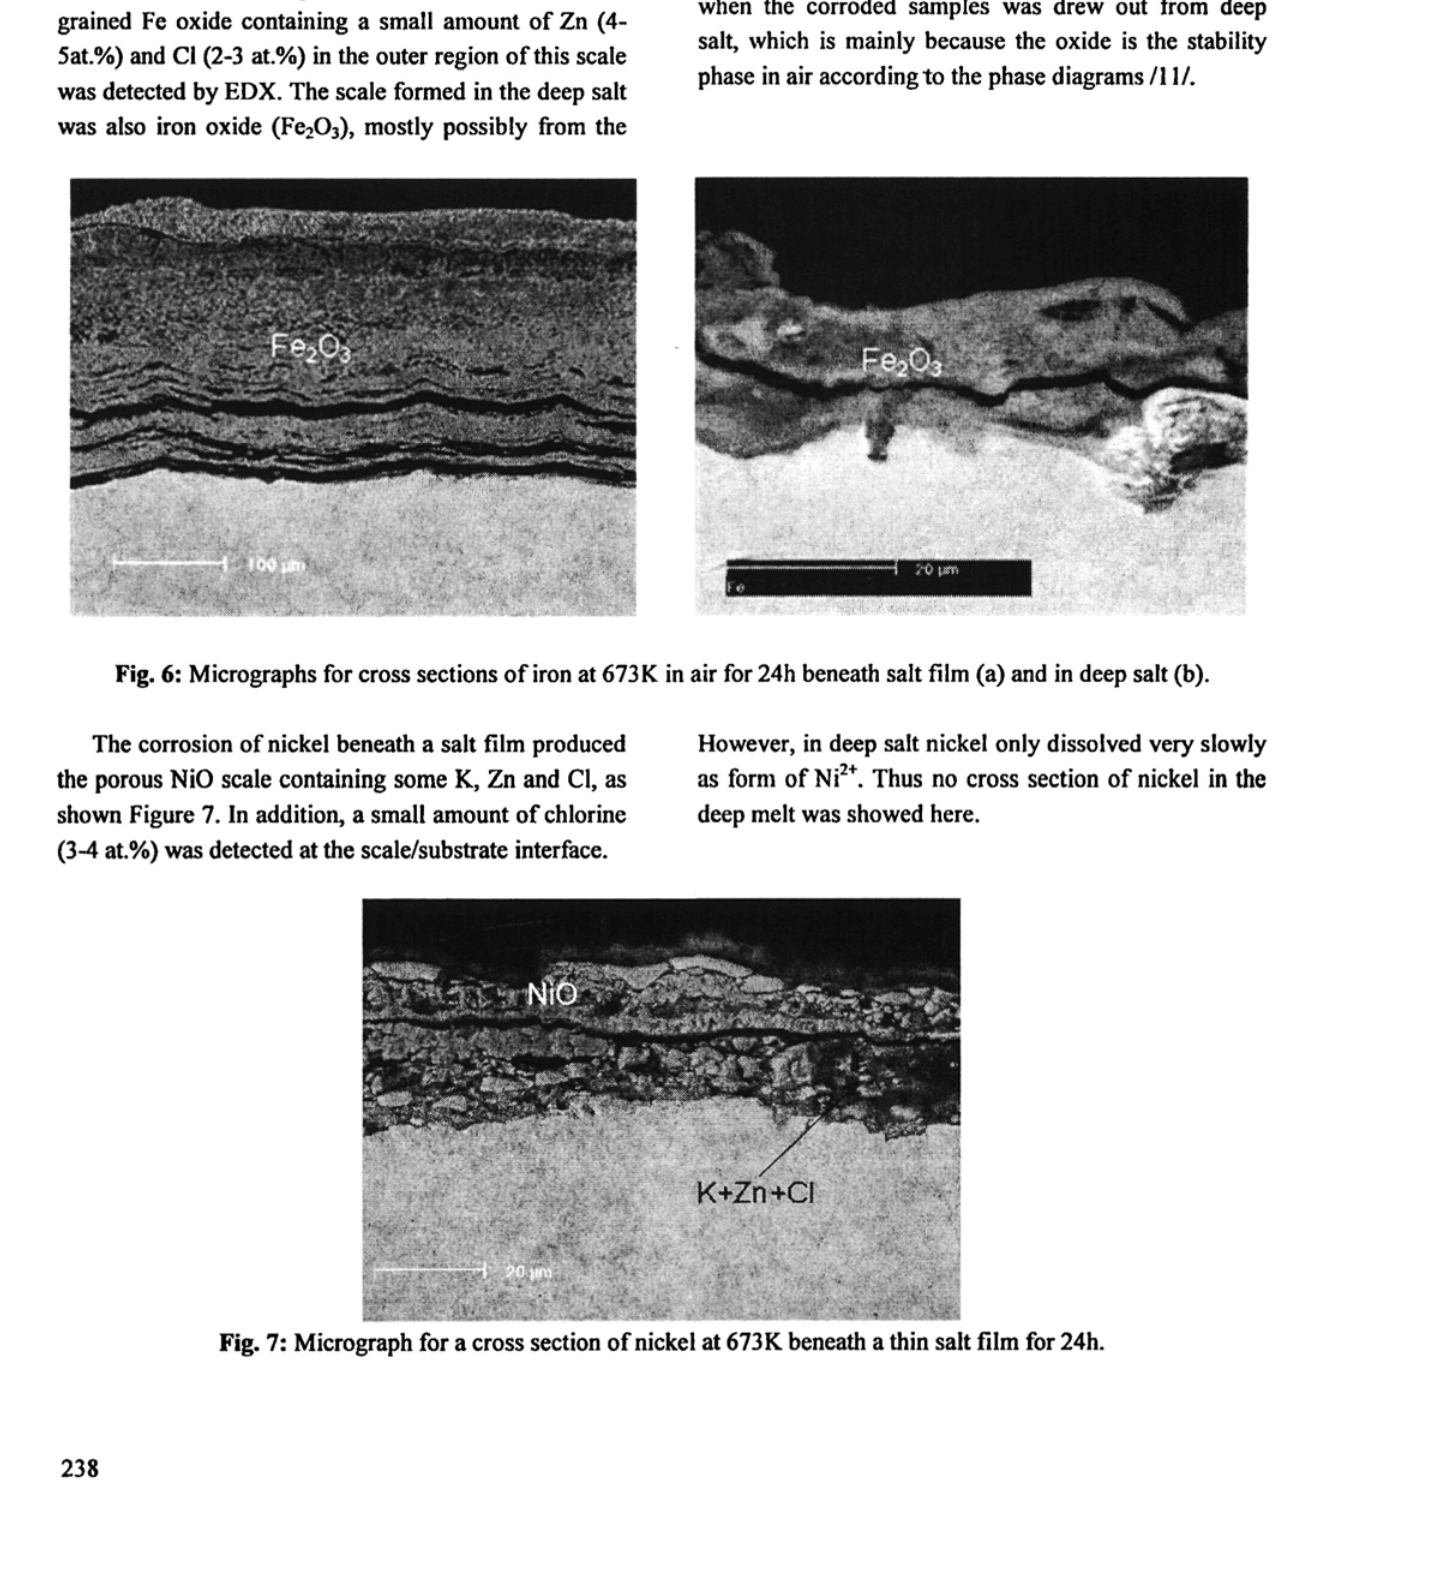
Fig. 7: Micrograph for a cross section of nickel at 673 Κ beneath a thin salt film for 24h.